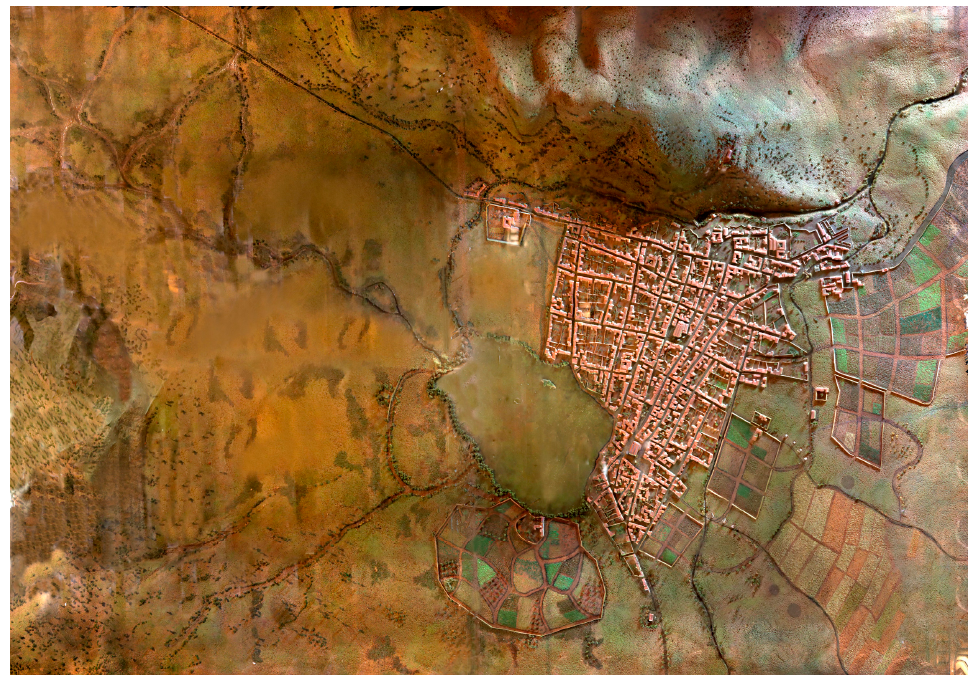
Figure 3. Physical model of San Cristobal de La Laguna from around 1588.